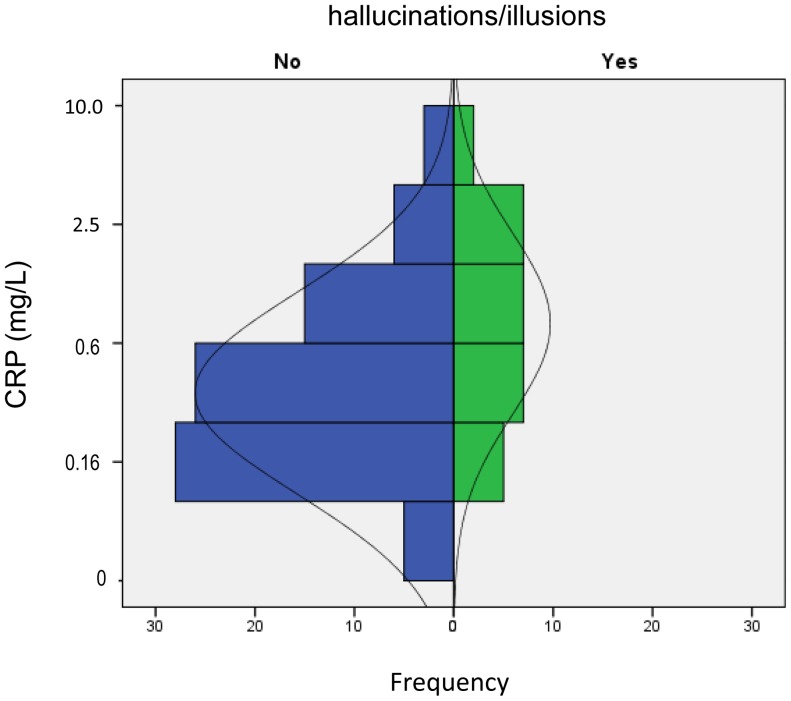
Pyramid histogram of CRP levels in cases (green) and controls (blue).Plasma CRP levels (expressed as log2CRP) were distributed as a bell-shape. They were shifted upward in cases compared with those in controls.